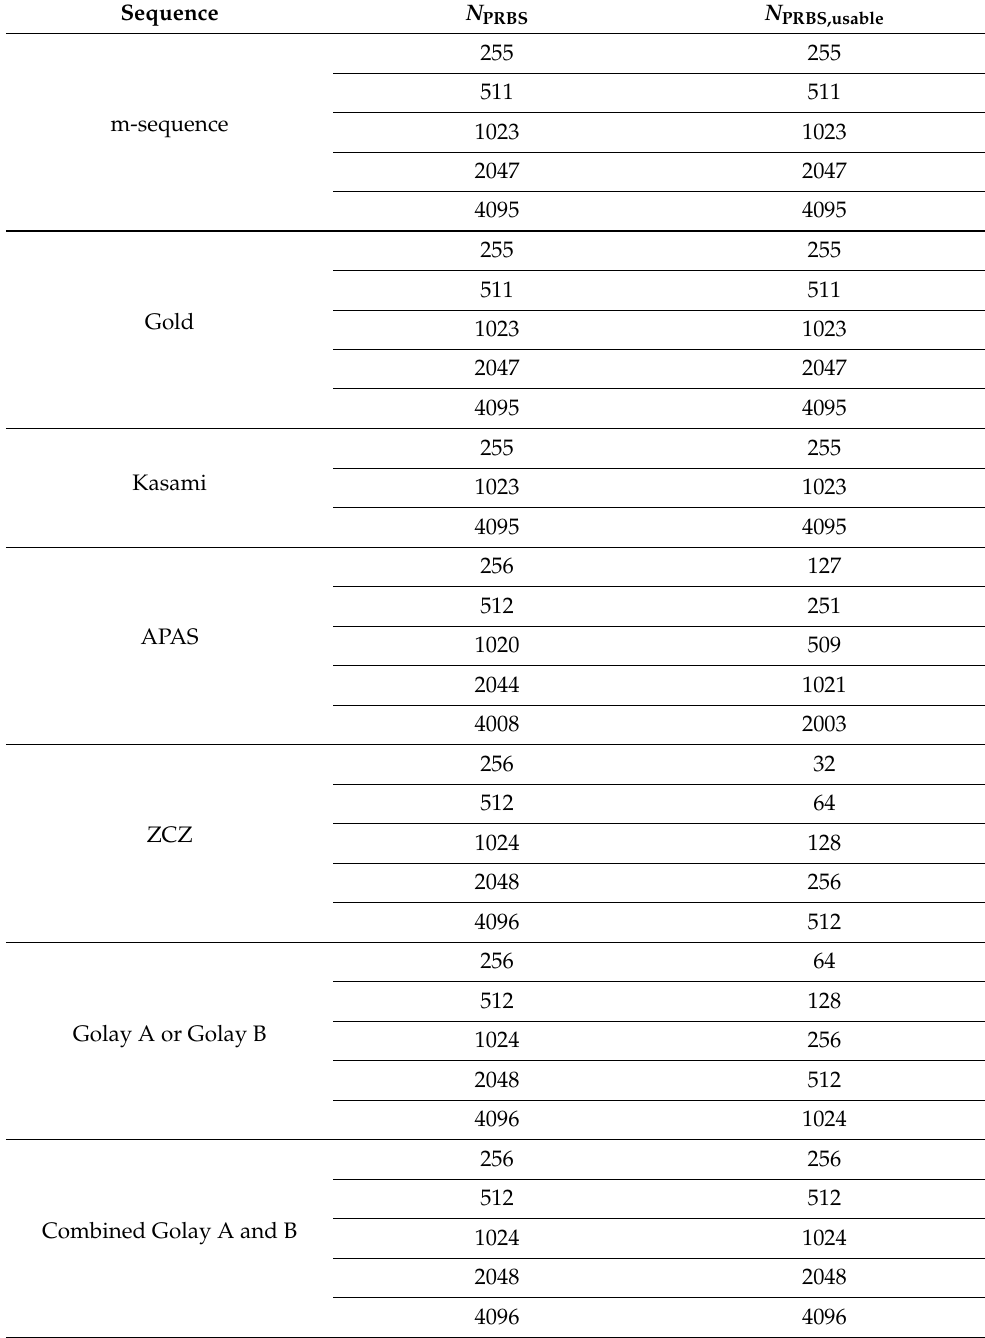
Table 1. Considered combinations of PRBS lengths N PRBS and usable PACF lengths N PRBS,usable for the investigated